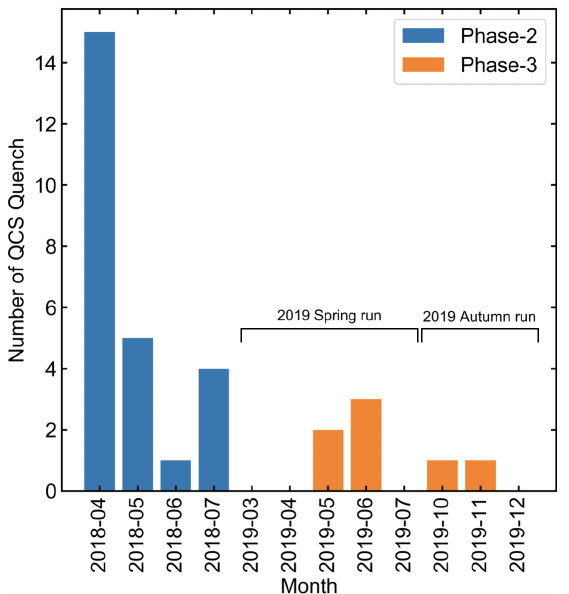
discharge occurred up to 940 mA with 1578 bunches.